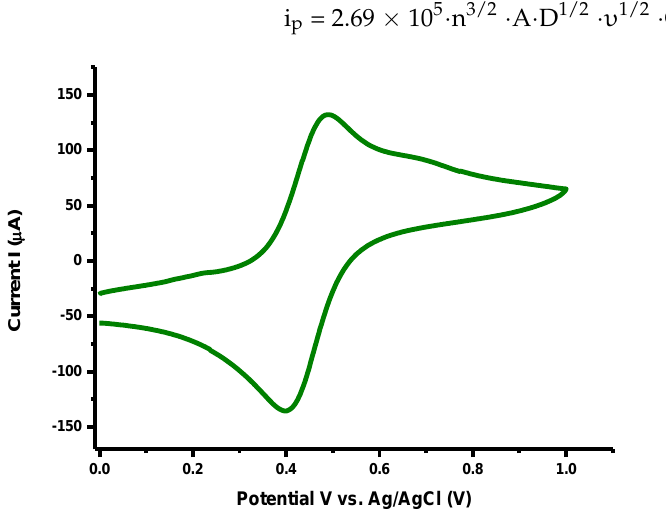
Figure 8. Cyclic voltammogram Fe 2+ /Fe 3+ redox couple on Ti 3 C 2 T x /Ag 2 CrO 4 modified GCE in 5 mMK 4 [Fe (CN) 6 ]) + 3M KCl at 100 mVs -1 .